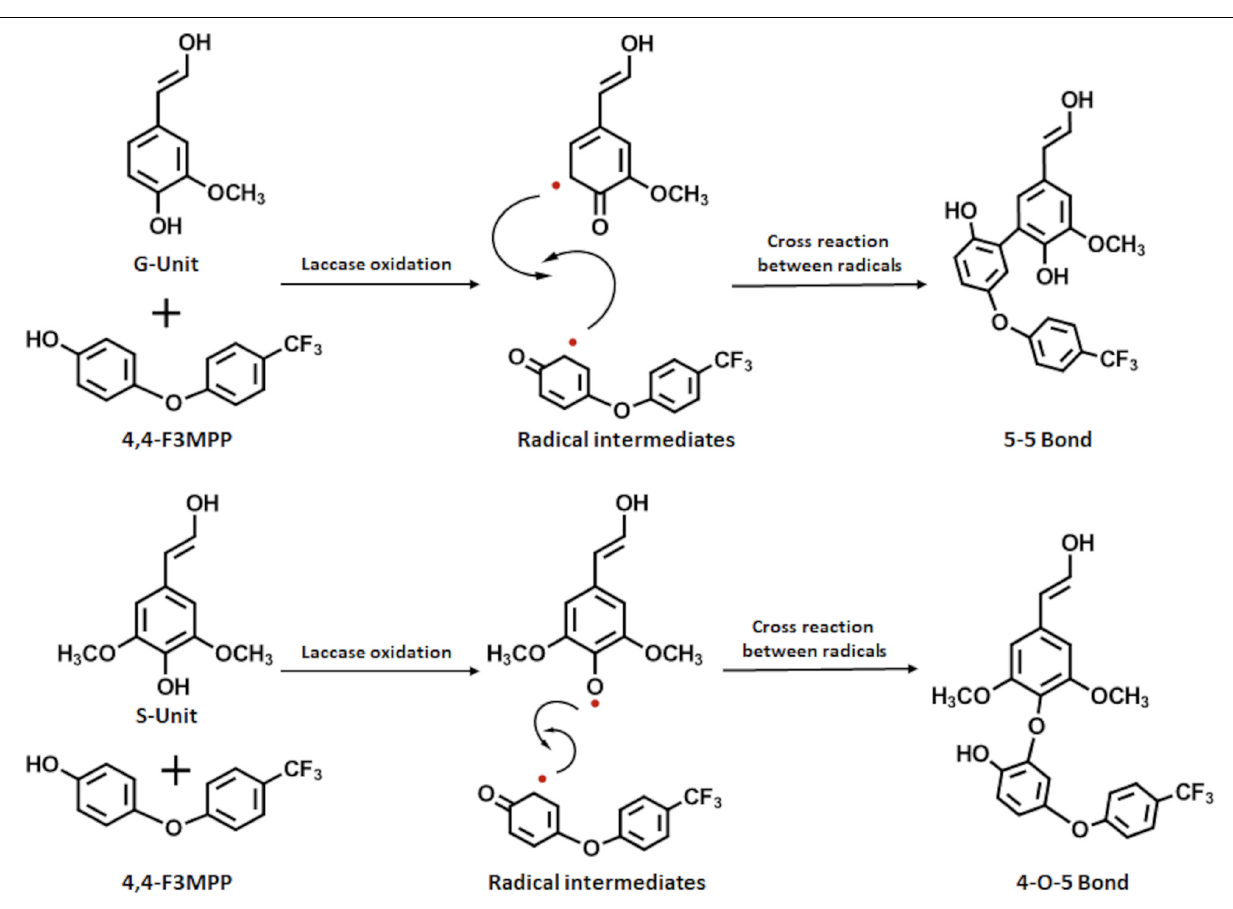
FIGURE 6 | Scheme for the reaction between LS and FP modified from Kudanga et al. (2010). Laccase oxidation induces radical formation on both the LS and the FP leading to covalent bonds between the substrates. G units mainly form 5–5 bonds, while S units primarily form 4-O-5